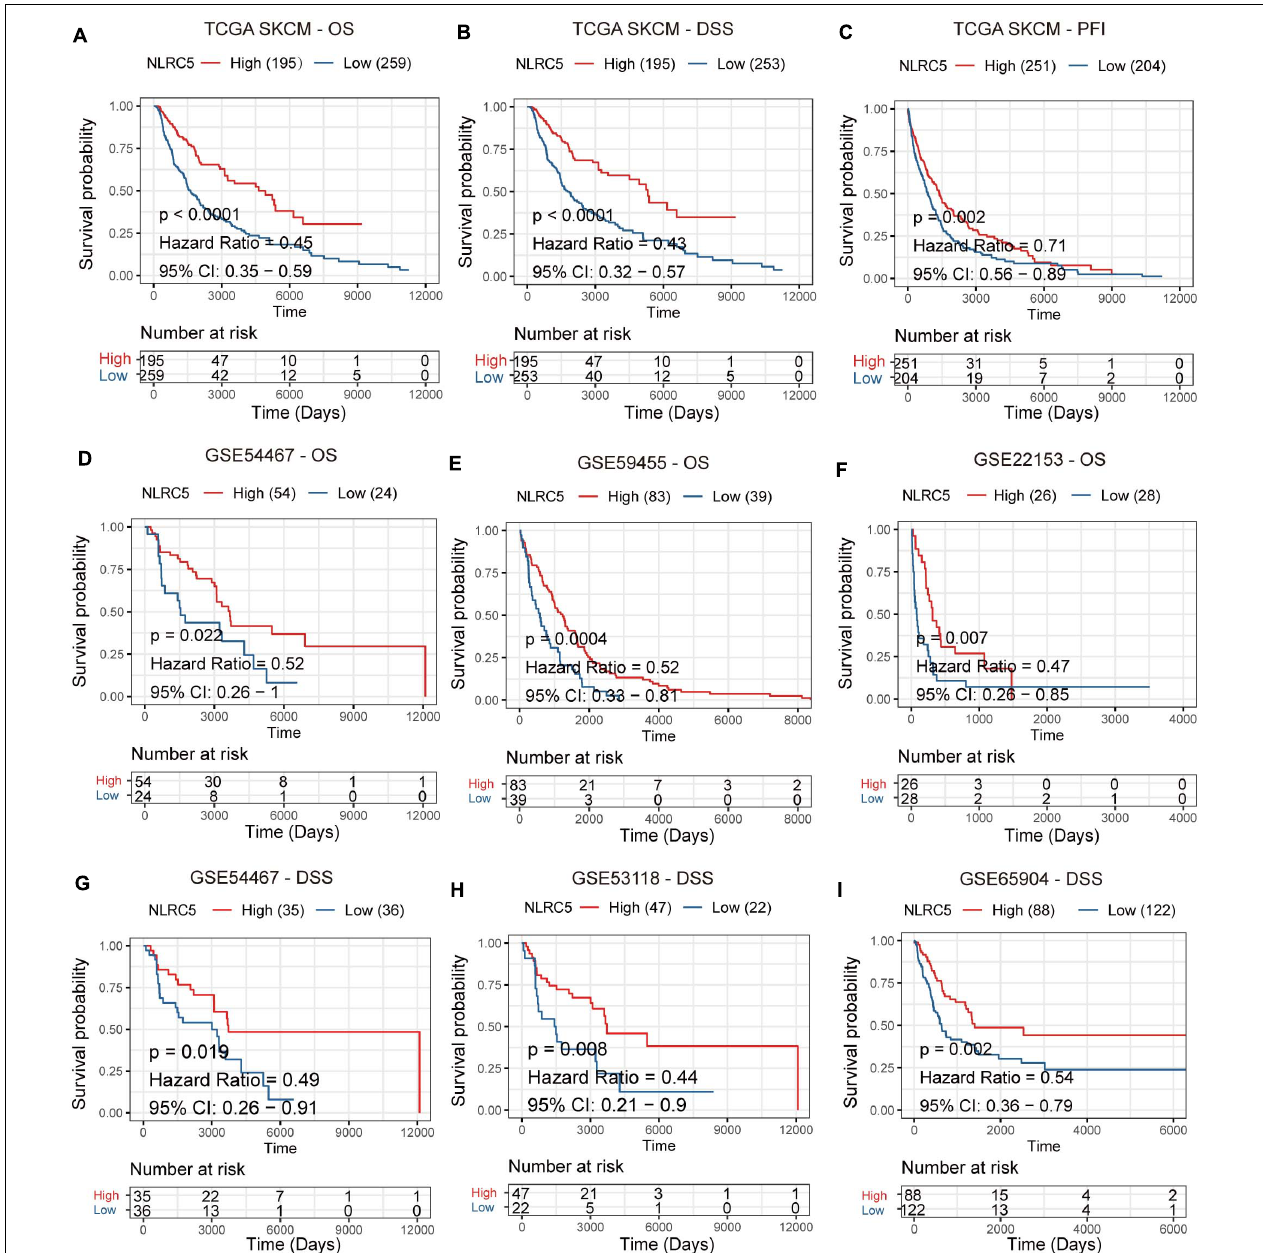
FIGURE 2 | Prognostic value of NLRC5 expression in the melanoma. (A–C) Kaplan–Meier analysis of OS (overall survival), DSS (disease-specific survival), and PFI (progression-free interval) of patients with melanoma according to the NLRC5 expression in TCGA SKCM dataset. (D–F) Kaplan–Meier analysis of OS (overall survival) of patients with melanoma according to the NLRC5 expression in GSE54467 (D) , GSE59455 (E) , and GSE22153 (F) melanoma datasets. (G–I) Kaplan–Meier analysis of DSS (disease-specific survival) of patients with melanoma according to the NLRC5 expression in GSE54467 (G) , GSE53118 (H) , and GSE65904 (I) melanoma datasets, respectively. The patients were stratified into high and low groups using the auto-select best cutoff determined by the R package “survminer.” Red: high NLRC5 expression group, green: low NLRC5 expression